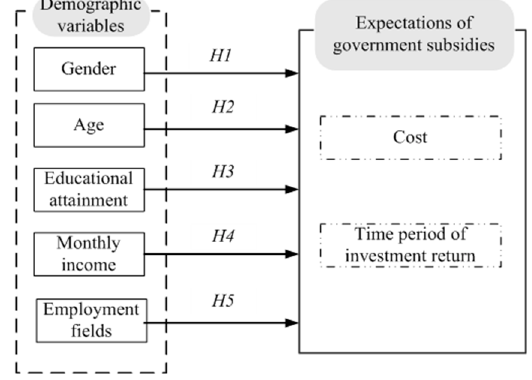
Figure 1. Proposed research model.